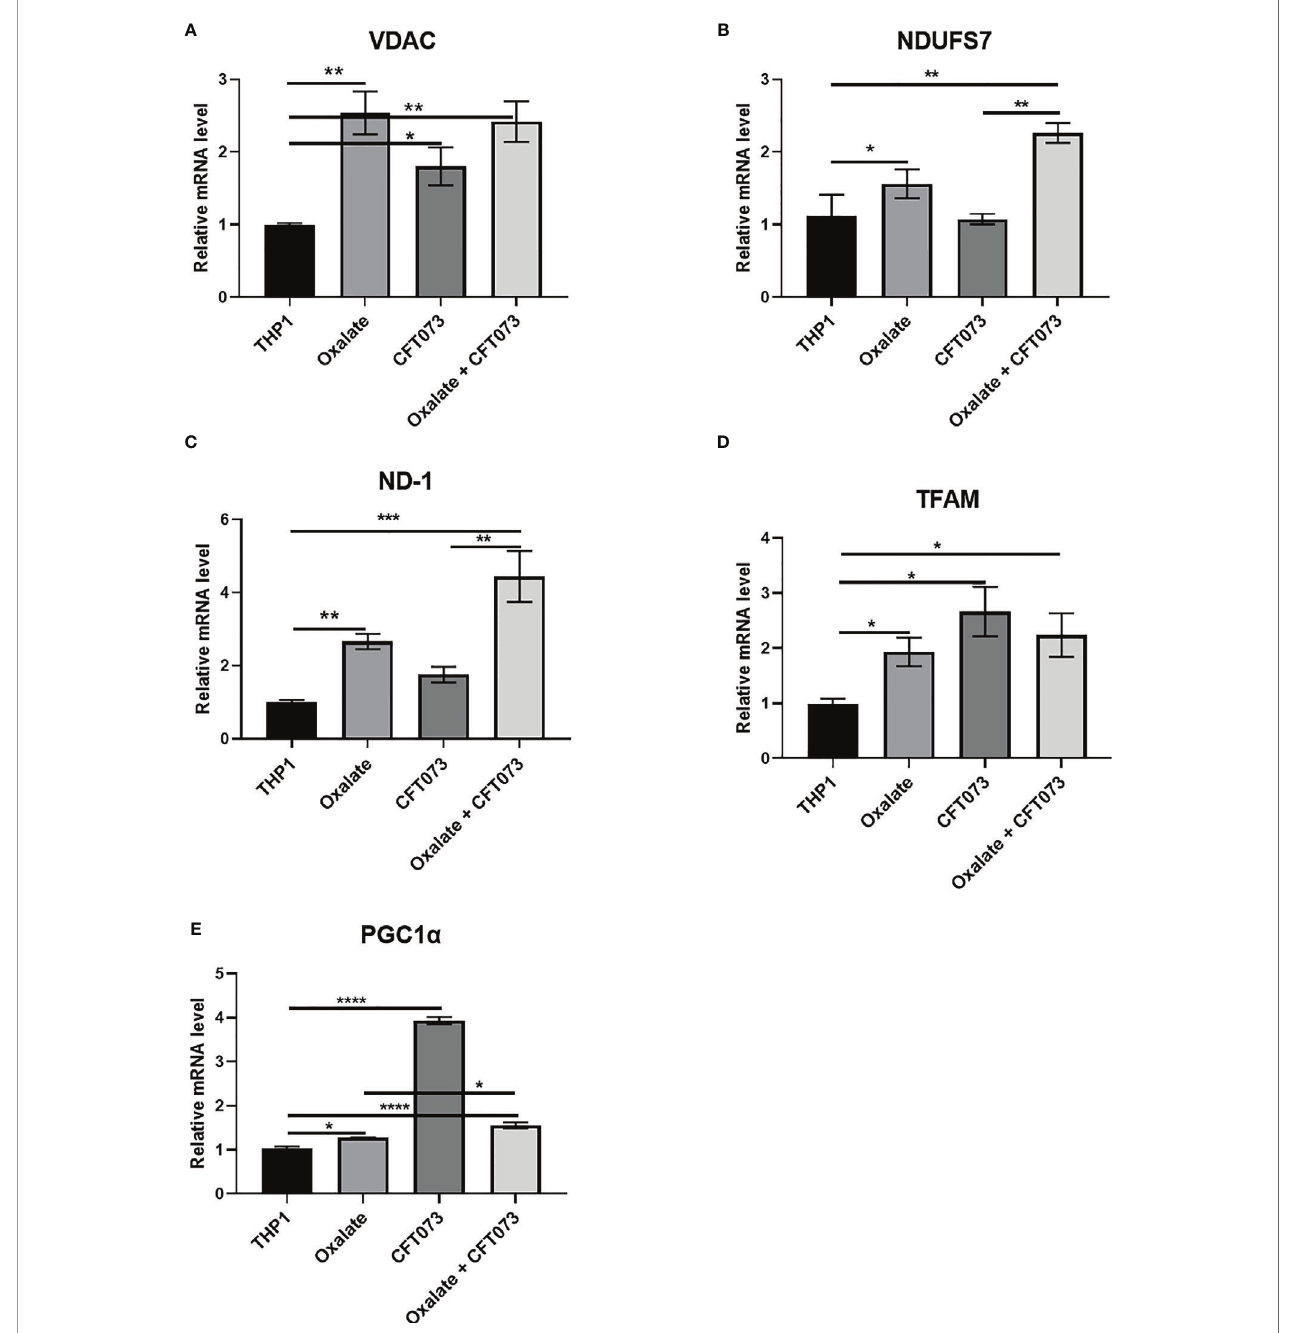
FIGURE 3 | Oxalate increases the expression of key mitochondrial genes in THP-1 macrophages. THP-1 macrophages were exposed to oxalate with or without CFT073 (MOI 1:2) as described in the Materials and Methods section. mRNA levels of mitochondrial genes: (A) VDAC1 (voltage dependent anion channel 1), (B) NDUFS7 (NADH : Ubiquinone Oxidoreductase Core Subunit S7), (C) ND-1 (NADH dehydrogenase 1), (D) TFAM (Transcription Factor A, Mitochondrial), and (E) PGC1 a (PPARG Coactivator 1 Alpha) were determined. All experiments were performed at least three times with n=5 replicates. Data are expressed as mean ± SEM. *p < 0.05, **p < 0.01, ***p < 0.001, ****p < 0.0001 is signi fi cant compared to control THP-1 macrophages or CFT073